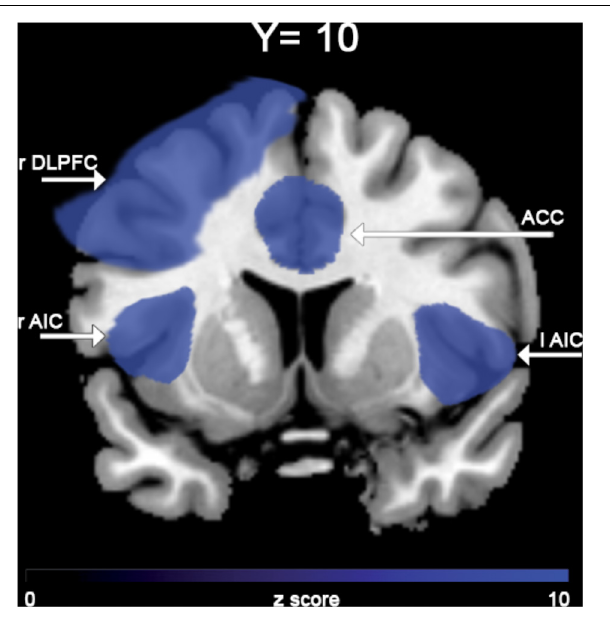
FIGURE 2 | Brain area negatively associated with DS-I scores in the “NoGO” vs. “GO”